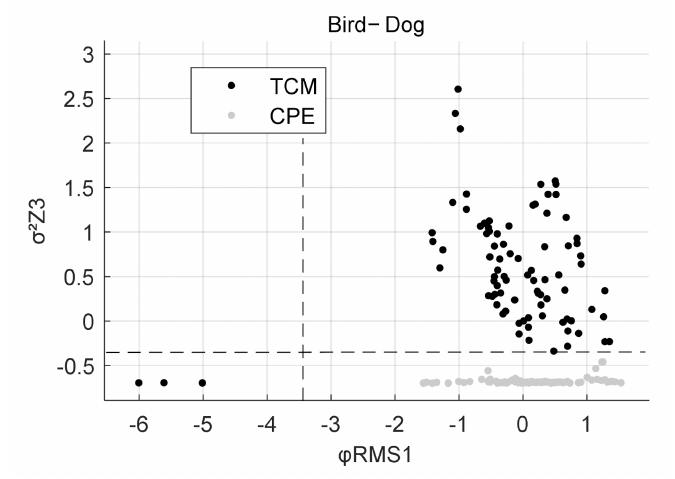
Figure 6. Scatter Plot for Bird-Dog with observations of TCM and CPE. Dashed lines at σ 2 Z3 = − 0.39 and ϕ RMS1 = − 3.28.